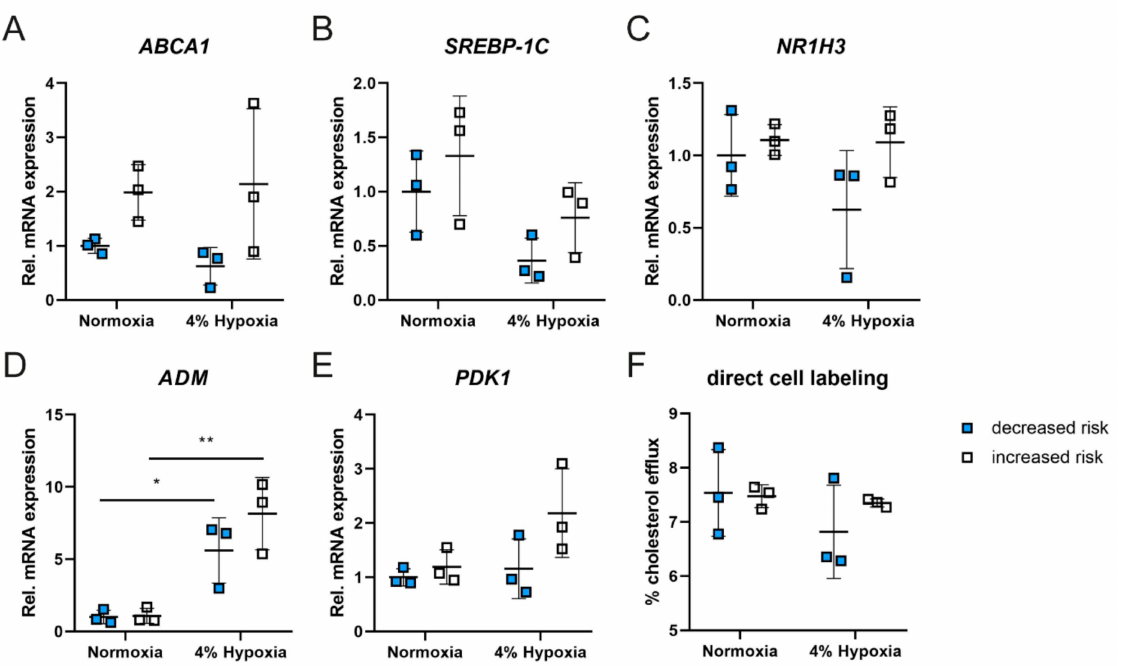
Figure 4. Gene expression and cholesterol efflux under hypoxia in patient-derived iRPEs. ( A – E ) Relative expression of ( A ) ABCA1 , ( B ) SREBP-1C , ( C ) NR1H3 , ( D ) ADM and ( E ) PDK1 mRNA in patient-derived iRPEs after 3 days under 4% O 2 (hypoxia) or 21% O 2 (normoxia). All data were normalized to RPL28 and are presented as means ± SD (n = 3). Two-way ANOVA with Tukey’s post hoc test. * p < 0.05; ** p < 0.01. ( F ) Cholesterol efflux assay in patient-derived iRPEs under 4% O 2 (hypoxia) or 21% O 2 (normoxia). Values shown are means ± SD (n = 3). Two-way ANOVA with Tuckey post hoc